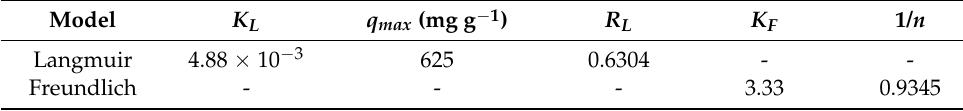
Table 6. Langmuir and Freundlich parameters for Cr(VI)